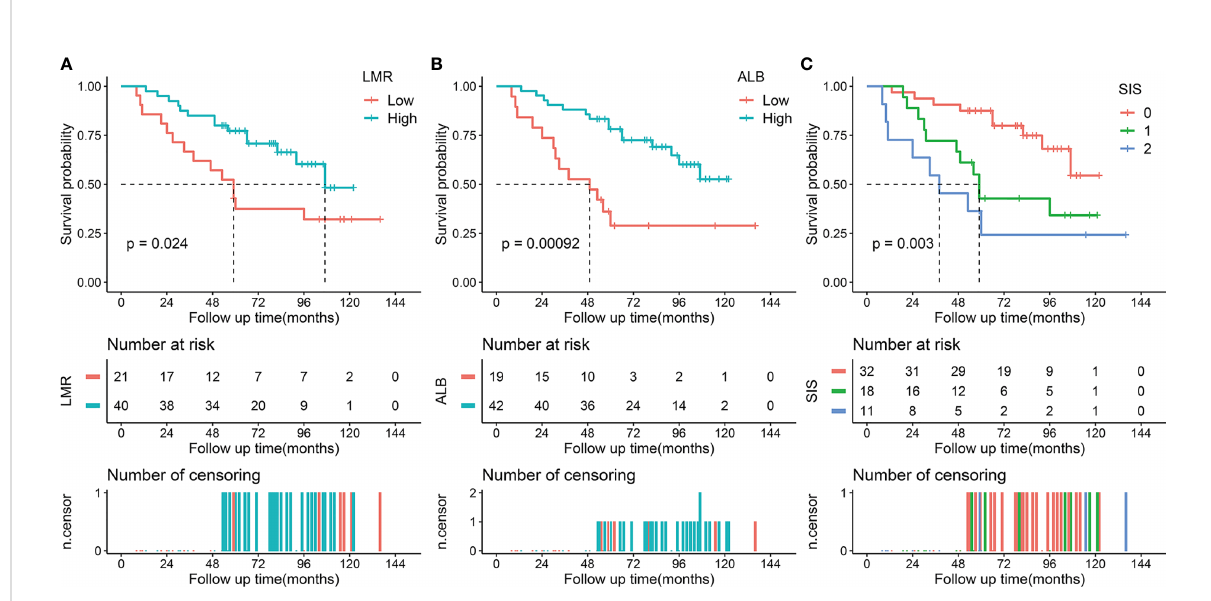
FIGURE 2 Kaplan-Meier survival analysis of LMR, ALB, and SIS in the validation cohort. (A) Low LMR correlated with a poor OS. (B) Low ALB correlated with an adverse OS. (C) High SIS was associated with a poor OS. LMR, lymphocyte to monocyte ratio; ALB, albumin; SIS, systemic in fl ammation score; OS, overall